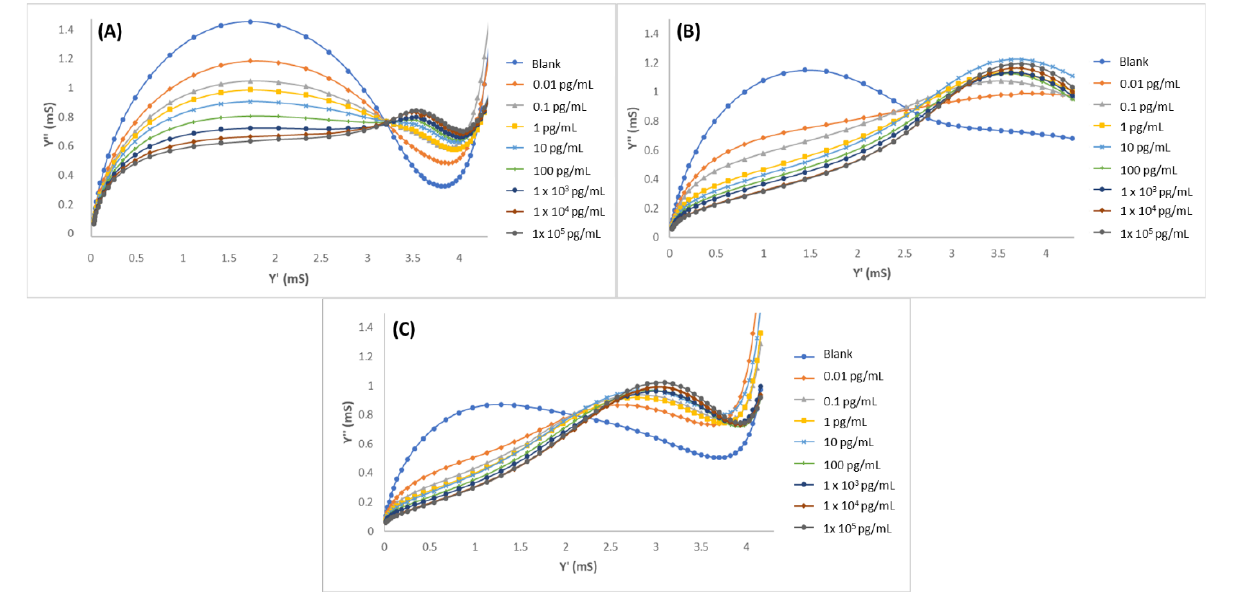
Figure 4. Admittance spectra of ( A ) MIPPy/GO@Fe 3 O, ( B ) NIPPy/GO@Fe 3 O 4 , and ( C ) MIPPy, after incubation with LYS in 0.01–1 × 10 5 pg/mL range.